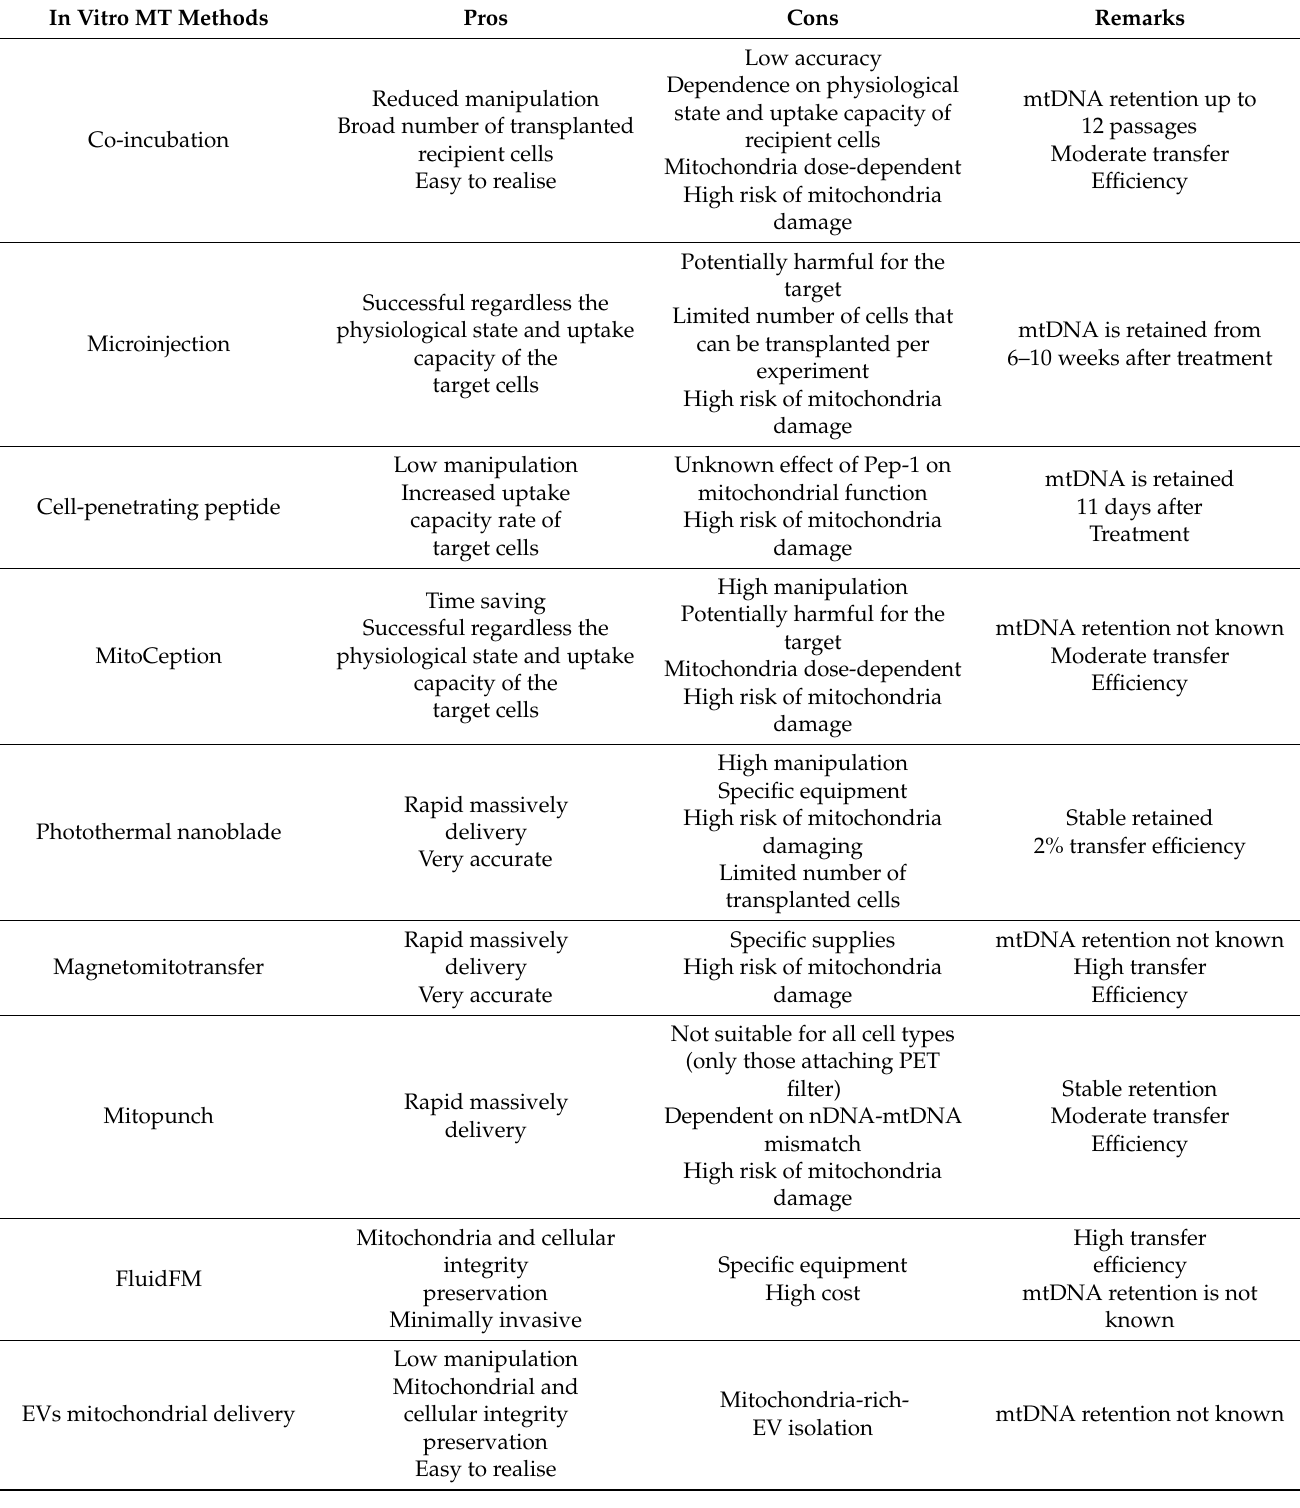
Table 1. A comparison of in vitro mitochondrial transplantation